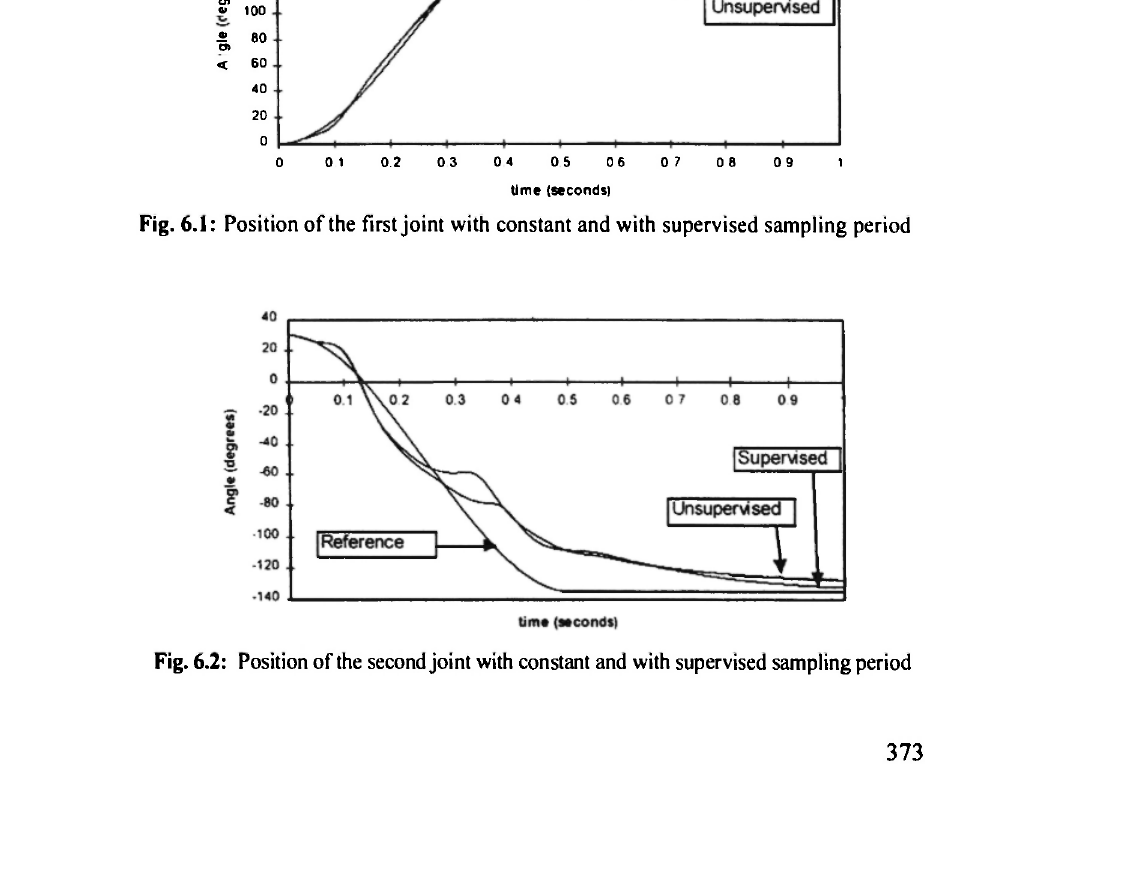
Fig. 5.2: Evolution of the supervised free-design parameter c k